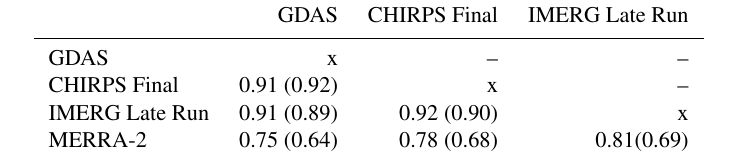
Yoon et al. (2019) show that their LSM ensembles of SCF have an average POD of 72 % and FAR of 36 %, which are within the range of our POD and FAR statistics (60 %–80 % POD; 20 %–40 % FAR) compared to MODIS SCF. The cat- egorical statistics indicate that Central Asia (GDAS) tends to have both a higher probability of detection and false alarm rate, indicating higher averages than MODIS SCF and global